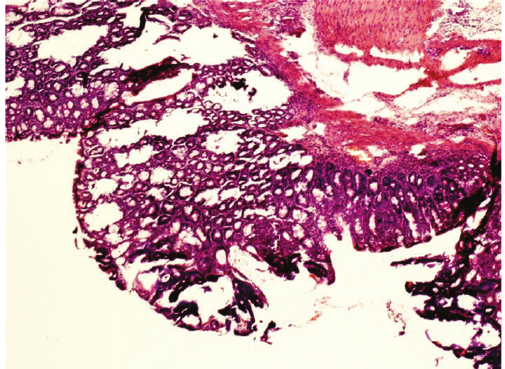
Figure 6: Colonic mucosa free from dysplastic foci in the area between the polyps in the AOM